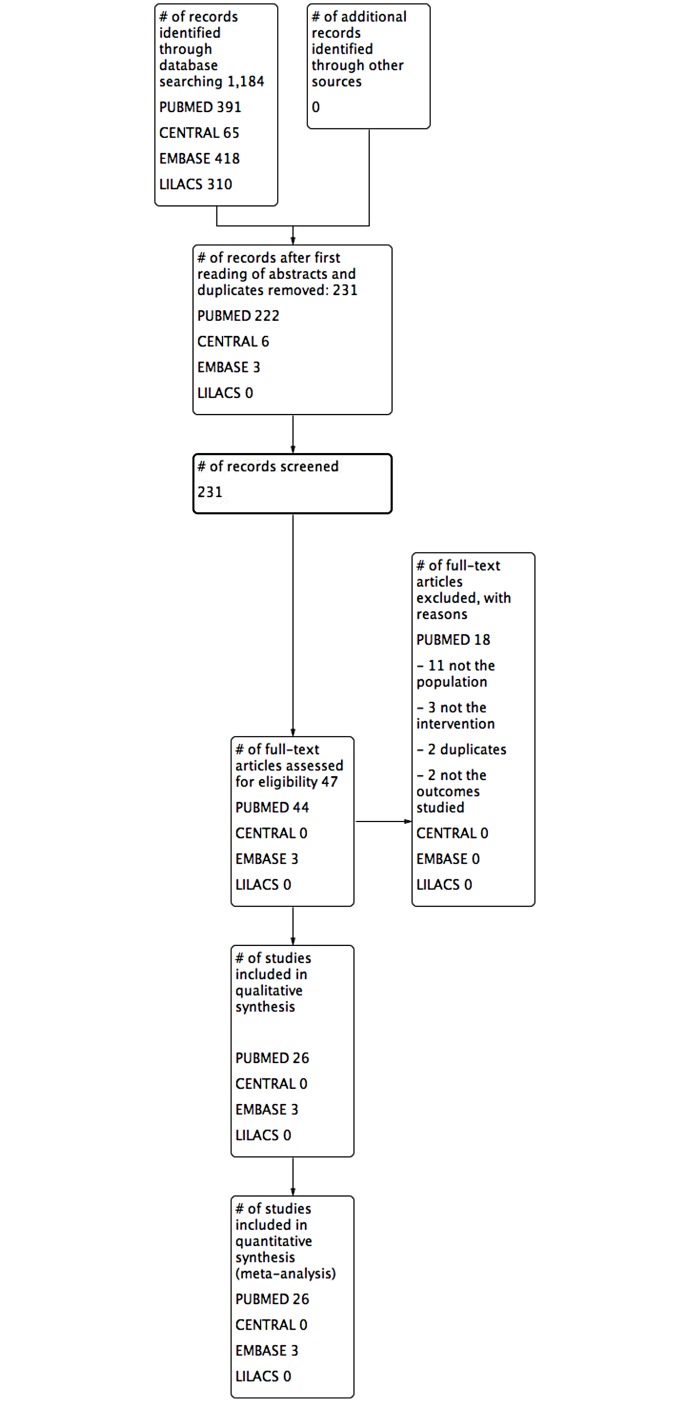
PRISMA flowchart.